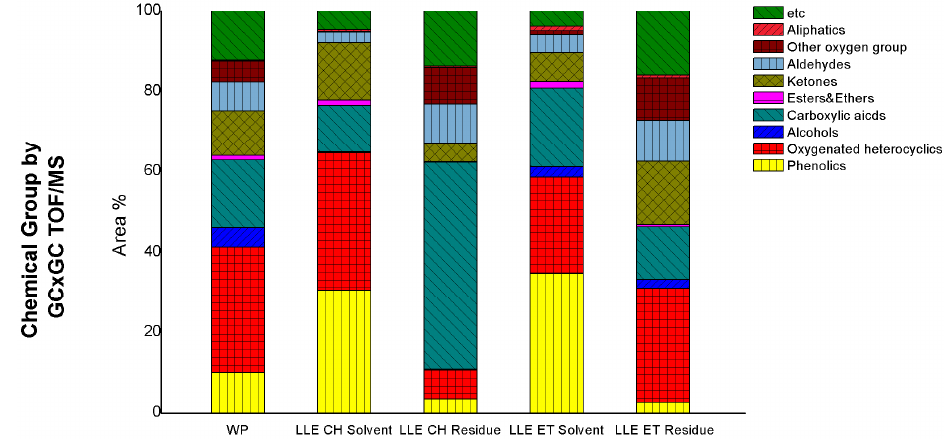
Figure 5. Chemical group compositions of WP and its liquid-liquid extraction fractions.